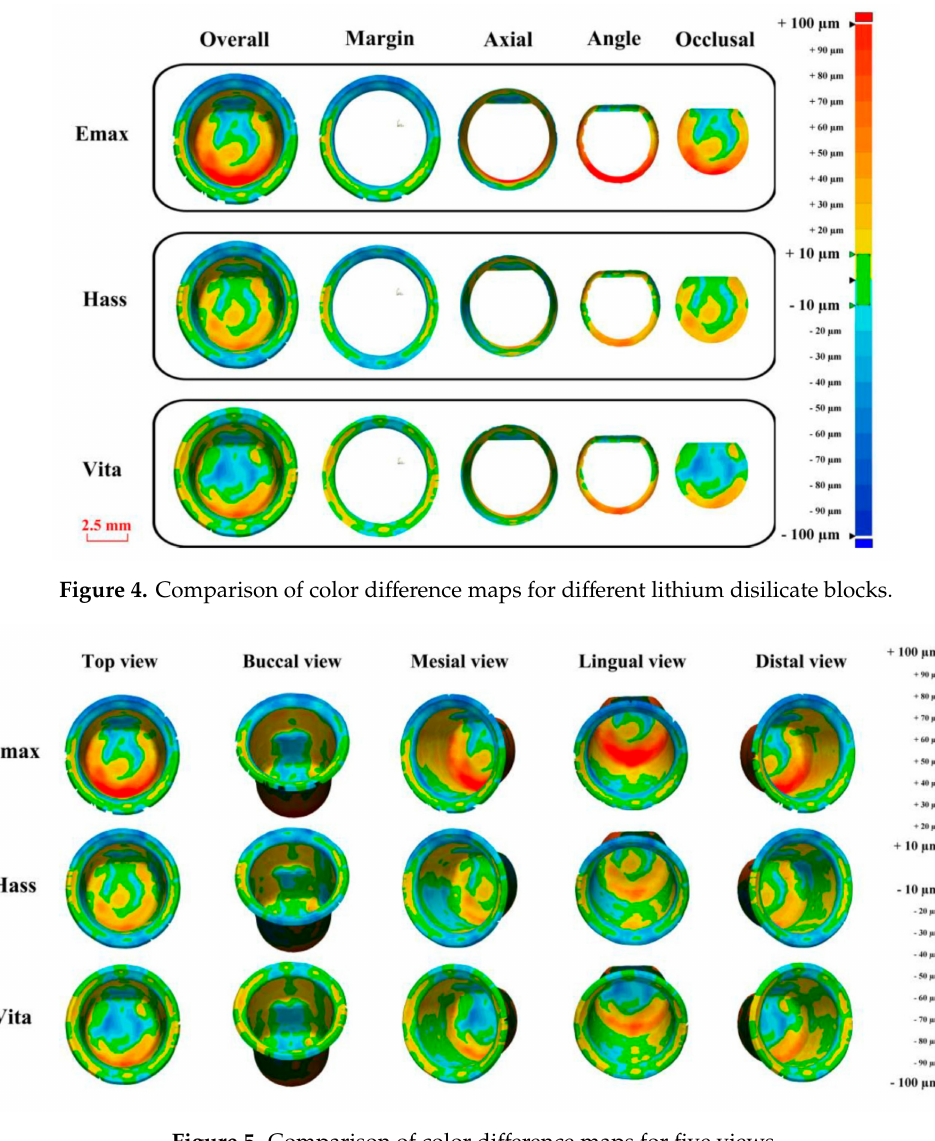
Figure 5. Comparison of color di ff erence maps for five